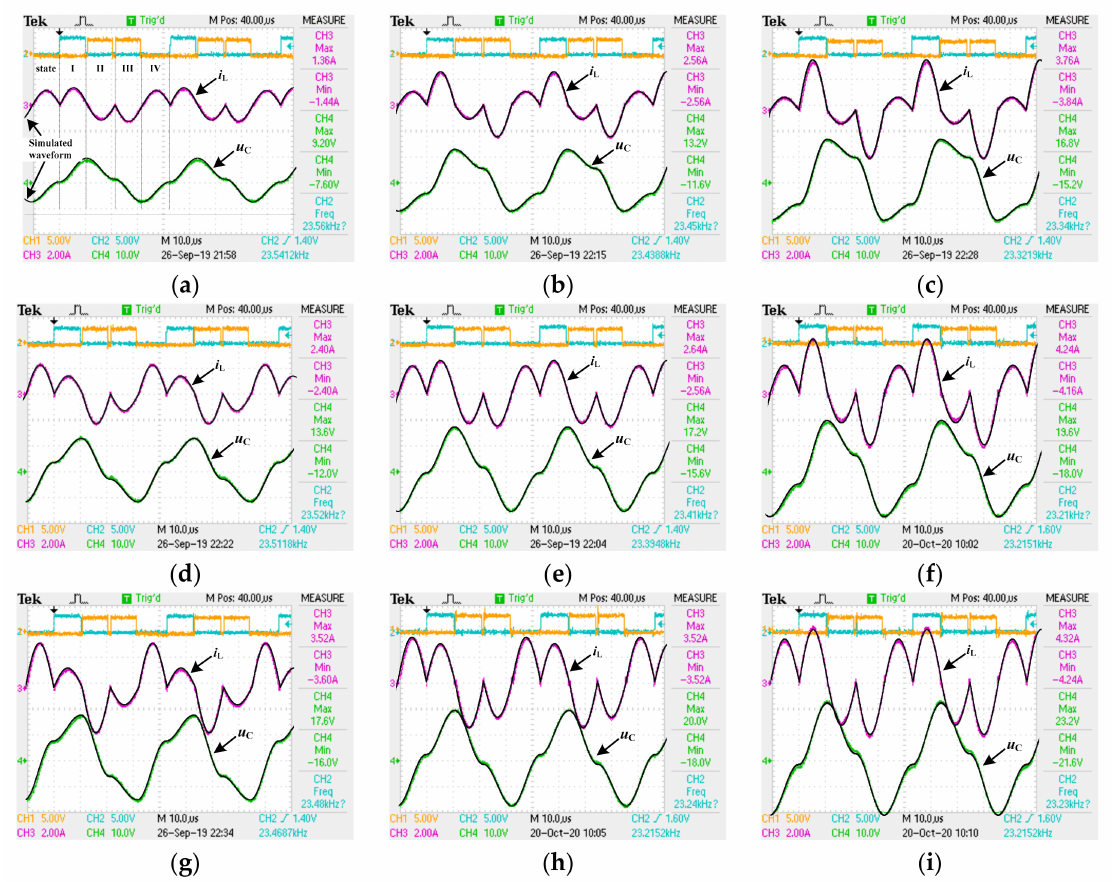
Figure 14. Experimental and simulated waveforms of the proposed BRLCC equalizer in different operation modes. ( a ) 1–1.